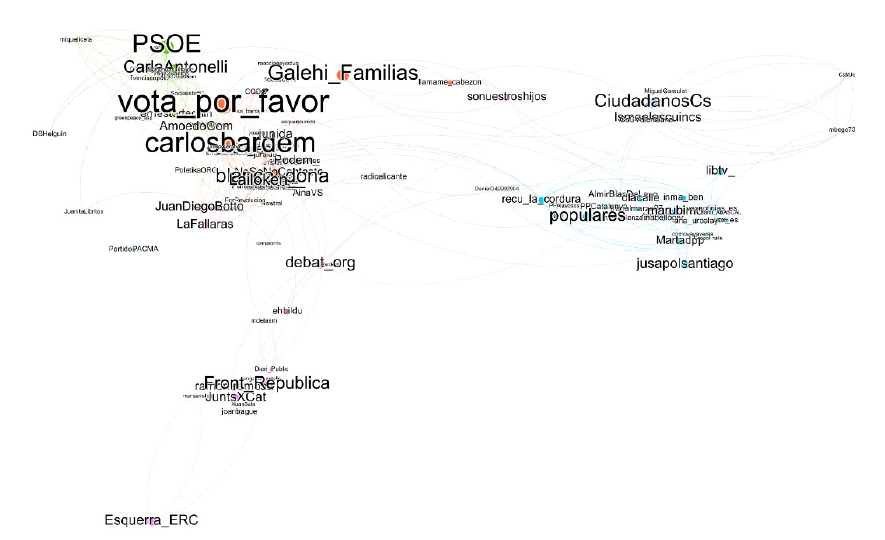
Figure 4. Bridges in the retweet network.